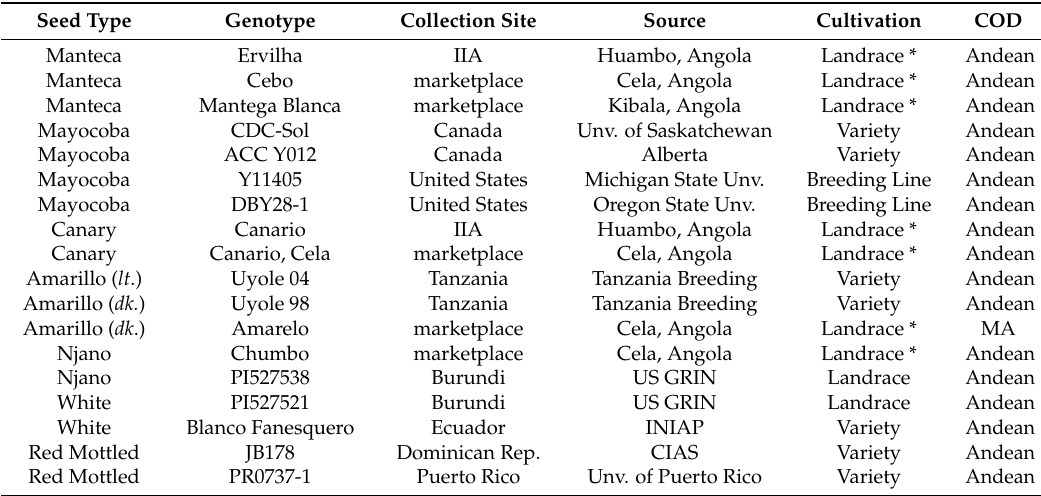
Table 1. Description, Collection Sites, Source, Cultivation Status and Center of Domestication (COD) of the Eighteen Genotypes that Characterize the Yellow Bean Panel (YBP) 1